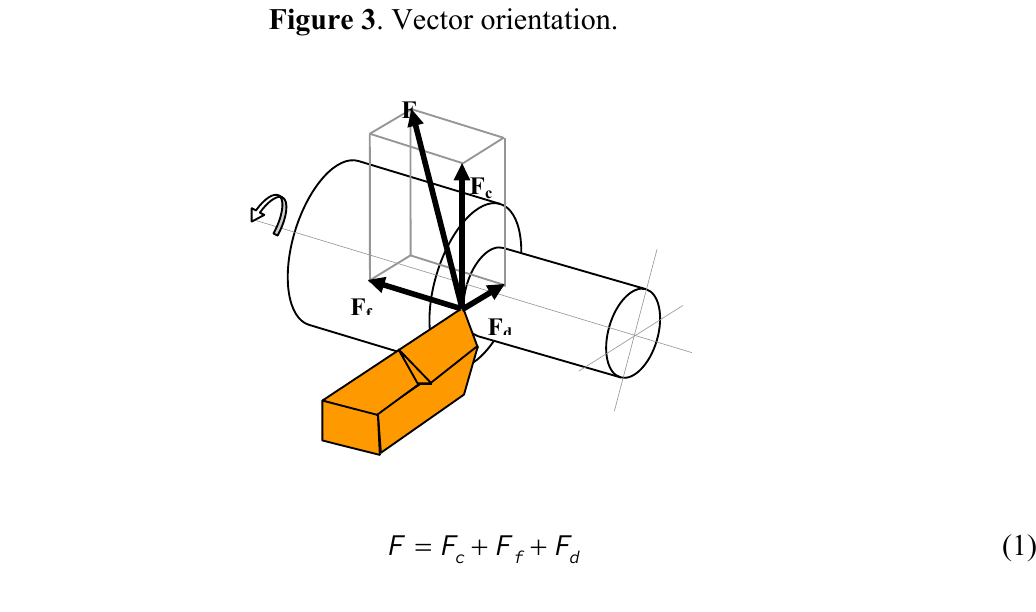
Figure 3 . Vector